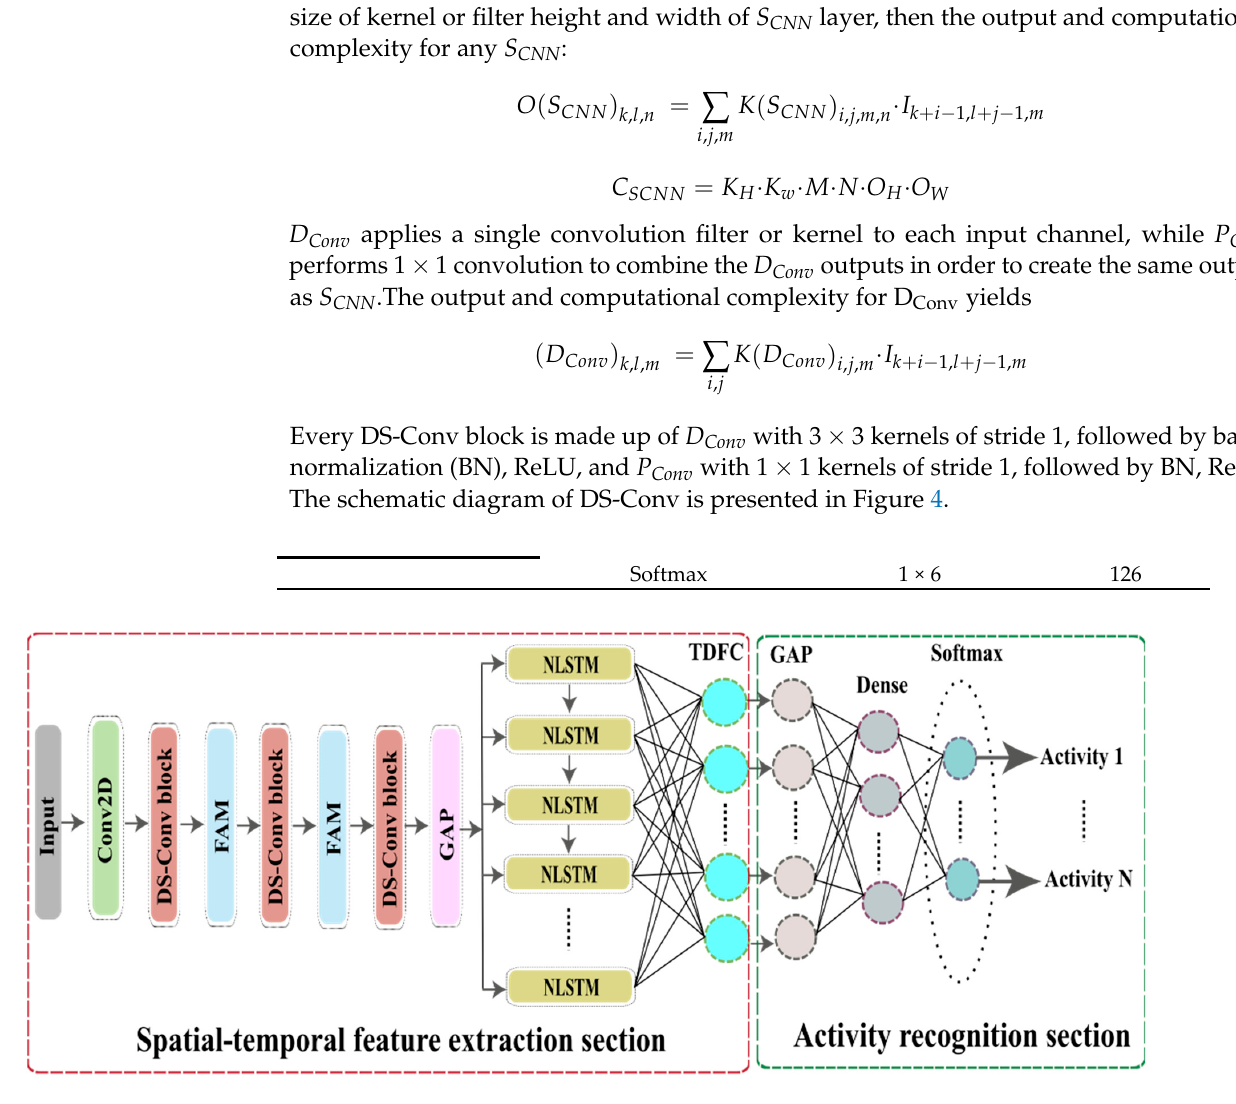
Figure 3. The schematic diagram of the STC-NLSTMNet model.